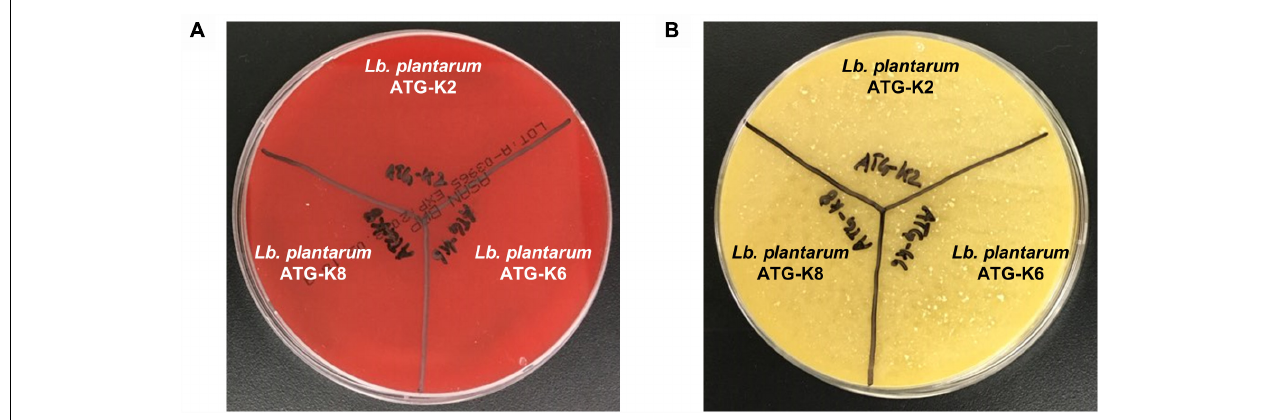
FIGURE 3 | Safety assessment results of L. plantarum ATG-K2, ATG-K6, and ATG-K8 of (A) hemolysis activity (B) biogenic amine production.